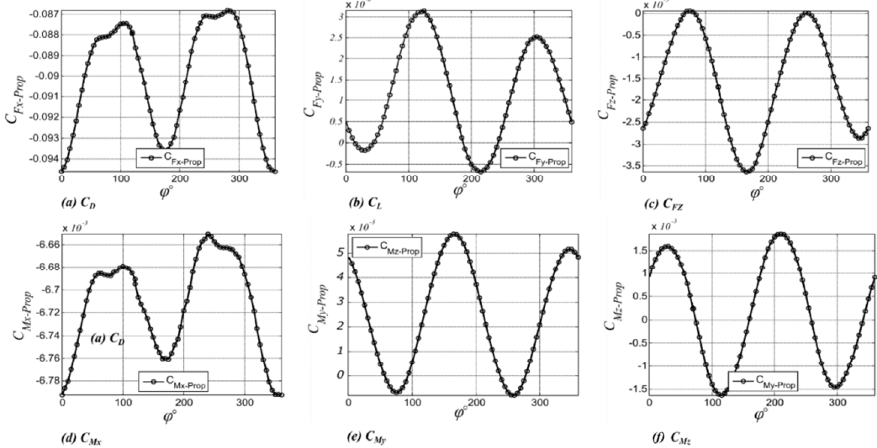
Figure 4. Propeller time history aerodynamic forces coefficient development, ( a ) drag coefficient, ( b ) lift coefficient, ( c ) side force coefficient, ( d ) rolling moment coefficient, ( e ) yawing moment coeffi- cient, and ( f ) pitching moment